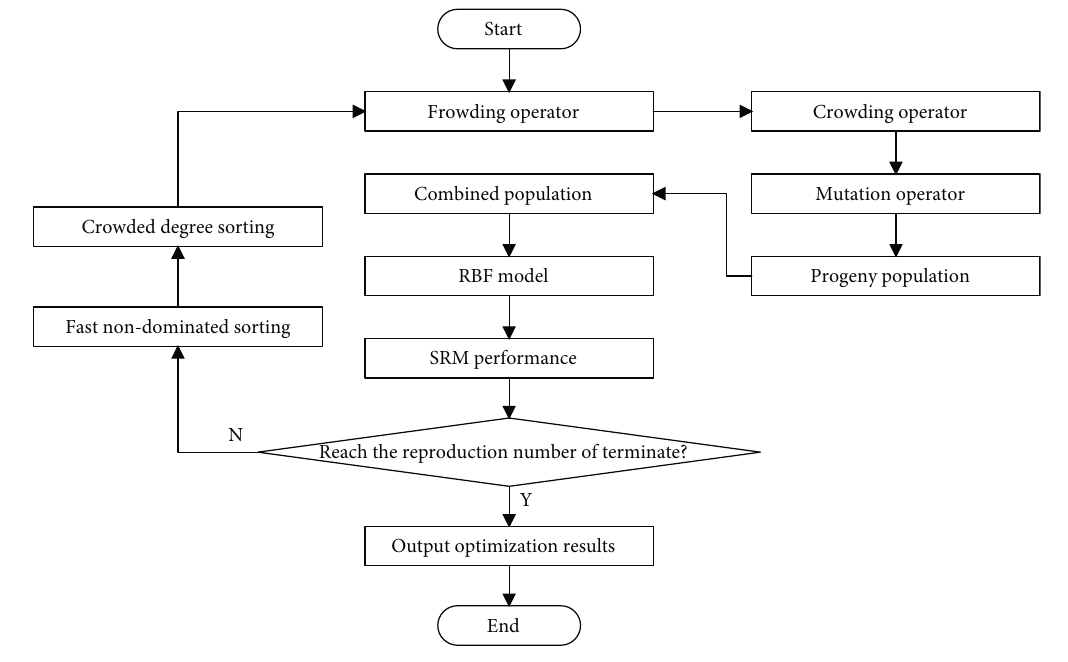
Figure 5: Flow chart of optimization based on the NCGA-II algorithm.